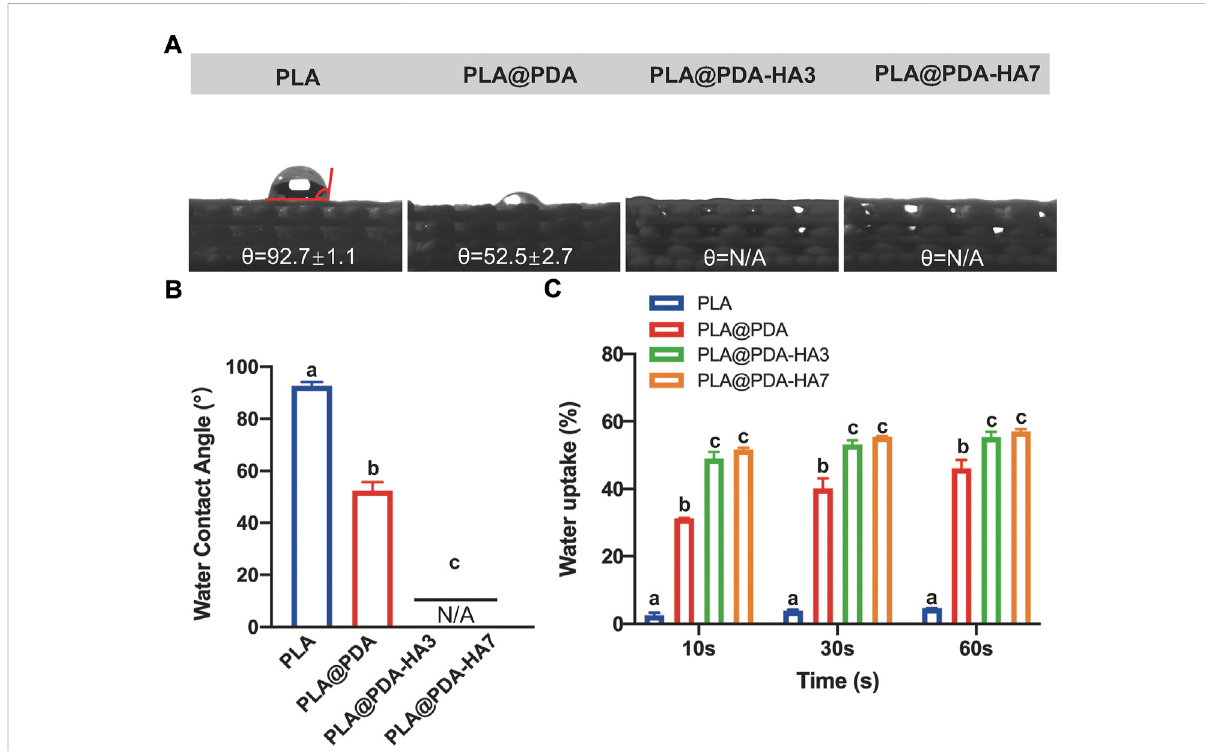
FIGURE 5 Hydrophilicity assay of PLA, PLA@PDA, PLA@PDA-HA3, and PLA@PDA-HA7 scaffolds. (A) Representative photographs of water droplets on the surfaceofeachscaffold. (B) Thewatercontactanglewithineachgroup. (C) WettabilityanalysisofeachscaffoldimmersedinPBSfor10,30,and60 s. Dissimilar letters indicate statistically signi fi cant differences between groups ( n = 6, p < 0.05).